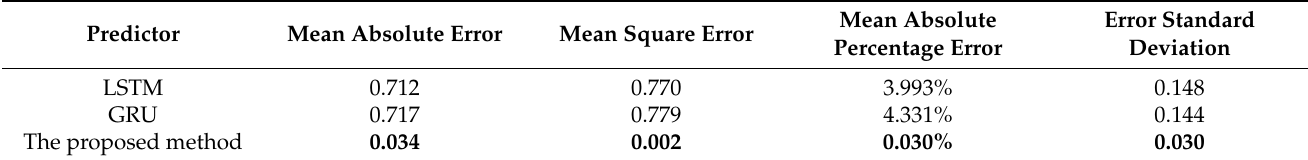
Table 7. Results of methods against unseen data.